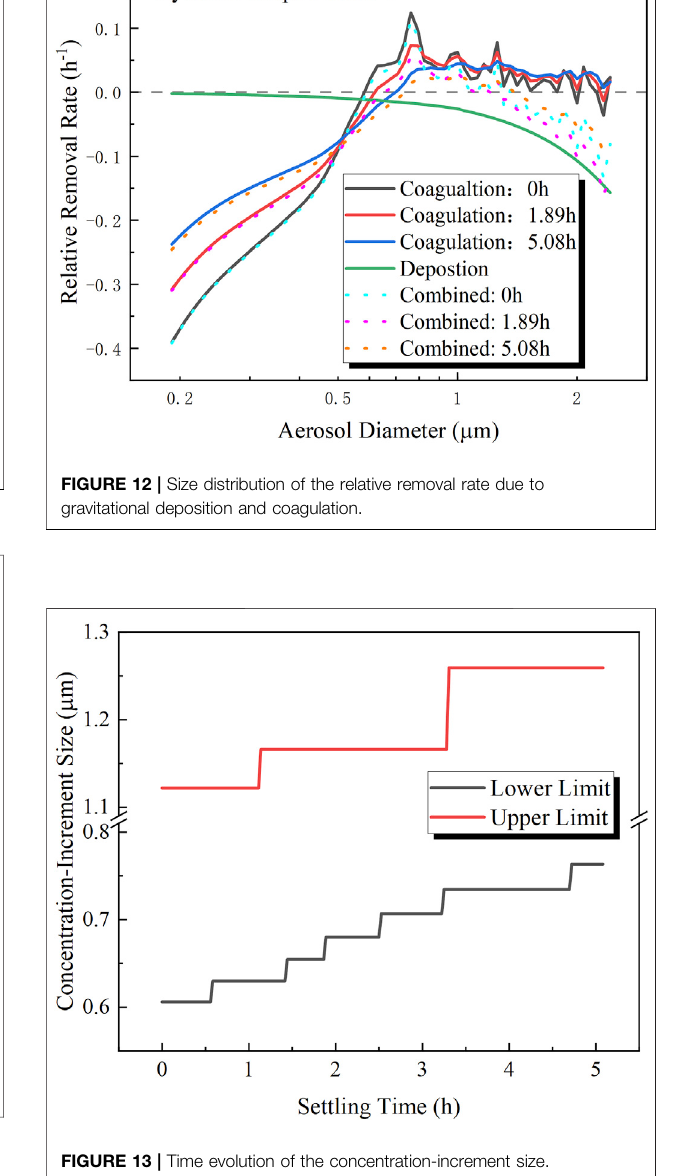
FIGURE 13 | Time evolution of the concentration-increment